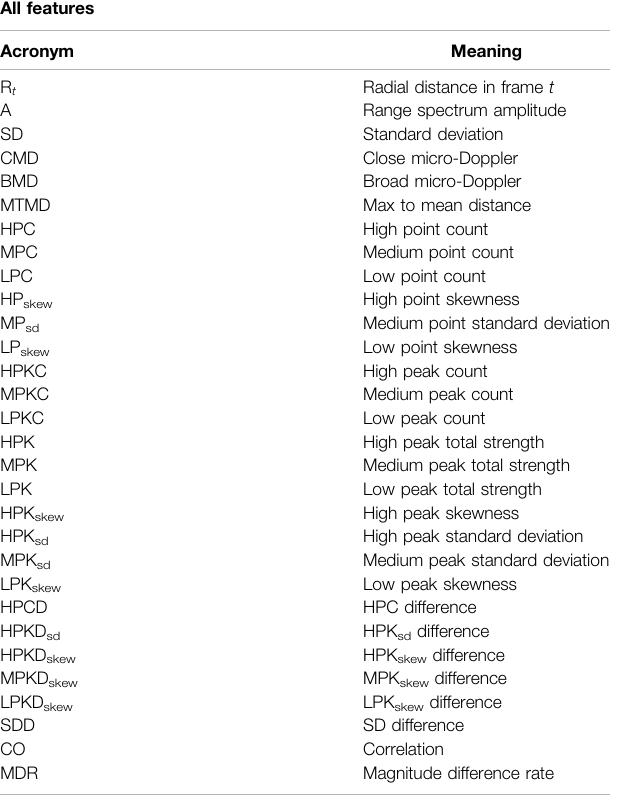
TABLE 3 | Notation of different features used throughout the